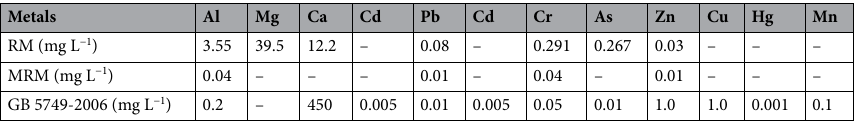
Table 6. Leaching metals results. “–” means not